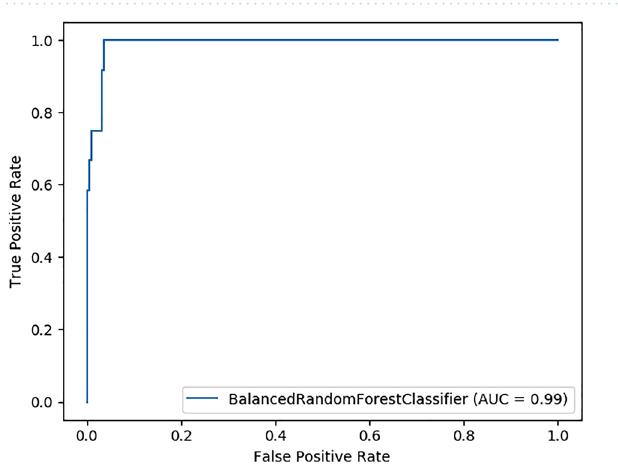
Table 1. Best hyperparameters suggested by Bayesian optimization. *Frame indicates the hyperparameters for treating imbalanced datasets.